Question: Write a single sentence explaining what this figure depicts.
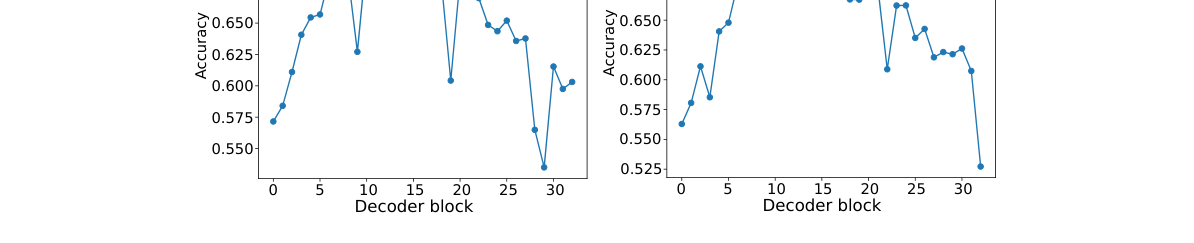
Answer: How does the LLM mix information among tokens according to ontology? We plot the performance (in terms of accuracy) of classifying whether two tokens are ontologically related, unrelated, or negatively related using their residual stream representations at different layers. We demonstrate the depth- wise accuracy profile using different numbers of few-shot examples (0 to 4). Typically, mixing information between tokens according to their relation does not require in-context learning. Information mixing between related (or negatively related) token pairs results in better distinguishability: gradually increasing from the starting decoder blocks and achieving a peak between decoder blocks 10-15.